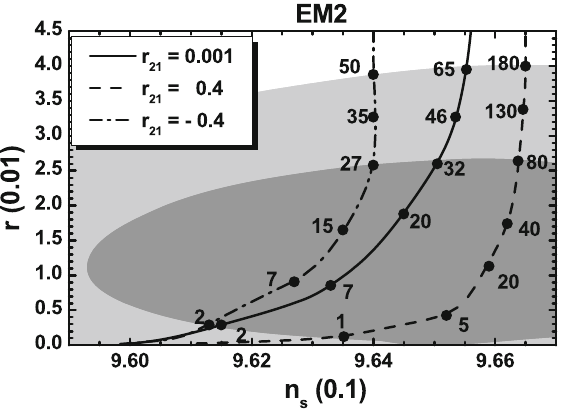
Fig. 4 Allowed curves in the n s − r plane for EM2 , M 1 = 0 . 01, and r 21 = 0 . 001 (solid line), r 21 = 0 . 4 (dashed line), r 21 = − 0 . 4 (dot-dashed line) or EM4 , M 2 = 0 . 01, and r 12 = 0 . 001 (solid lines),